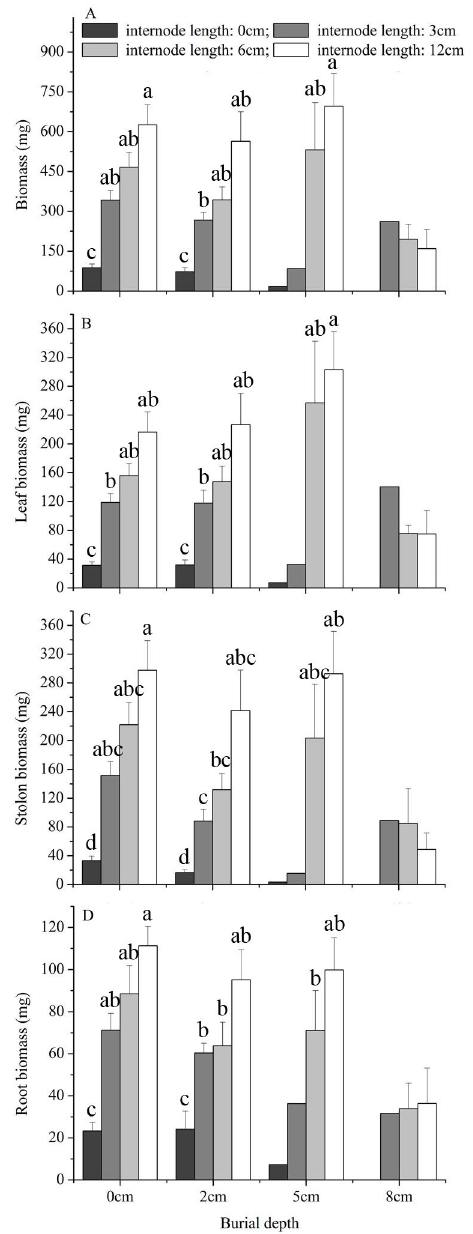
Figure 2. Effects of burial depth and stolon internode length on growth of Mikania micrantha . Total biomass, leaf biomass, stolon biomass and root biomass of the surviving fragments are given. Error bars represent the mean ± SE. One-way ANOVAs with post-hoc Duncan’s tests were used for the multiple comparison analyses (data were ln-transformed prior to analyses), and significant differences (at the significance level of P =0.05) between two treatments are marked with the use of different symbols.